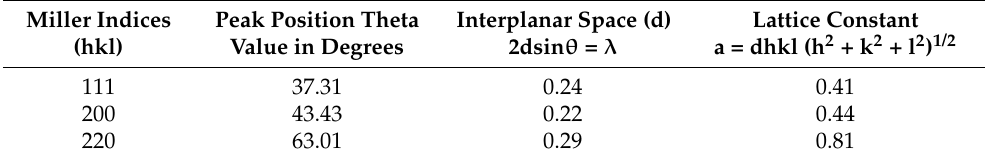
Table 1. Calculated interplanar spaces (d) and lattice constant